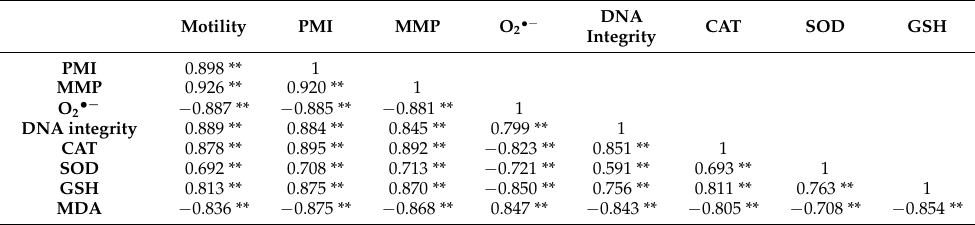
Table 2. Correlations among post-thaw sperm quality parameters, antioxidant activity, DNA integrity, and lipid peroxidation of saccharide supplemented cryopreserved sperm of Pacific abalone. Motility PMI